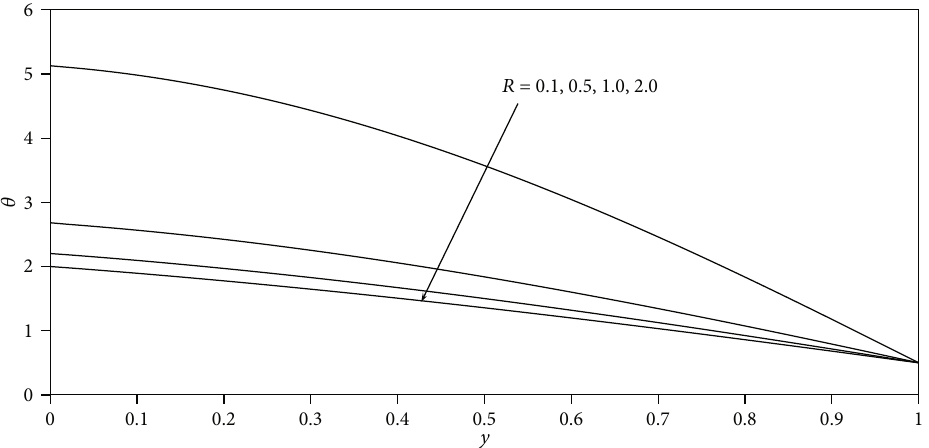
Figure 8: Temperature pro fi les for di ff erent values of R at ϕ = 2 : 0